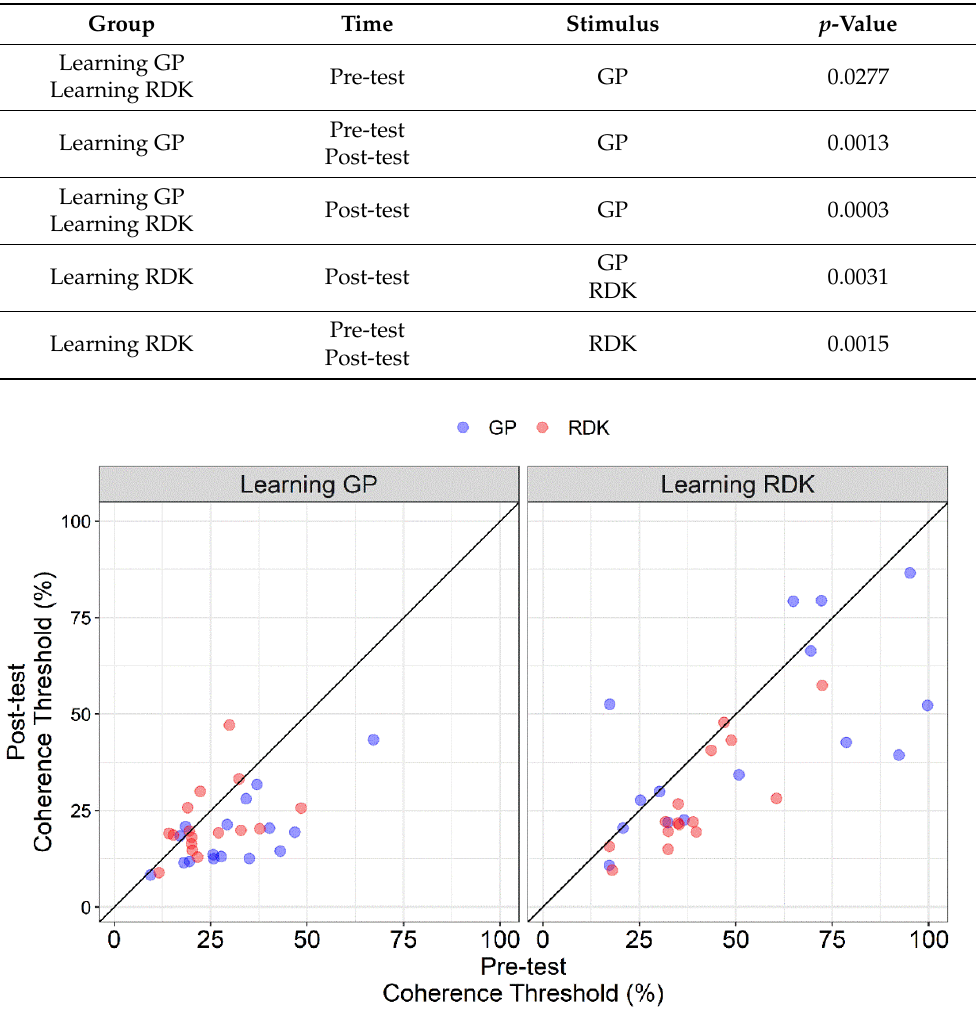
Figure 3. Scatter plot of the coherence thresholds (%) of individual participants in the pre-test and post-test assessments. Coherence thresholds are plotted separately for Glass patterns (GPs) and random dot kinematograms (RDKs) and learning group (i.e., learning GP and learning RDK). The diagonal line represents the same performance in the pre-test and post-test. All points falling under this line represent a better performance in the post-test than in the pre-test.